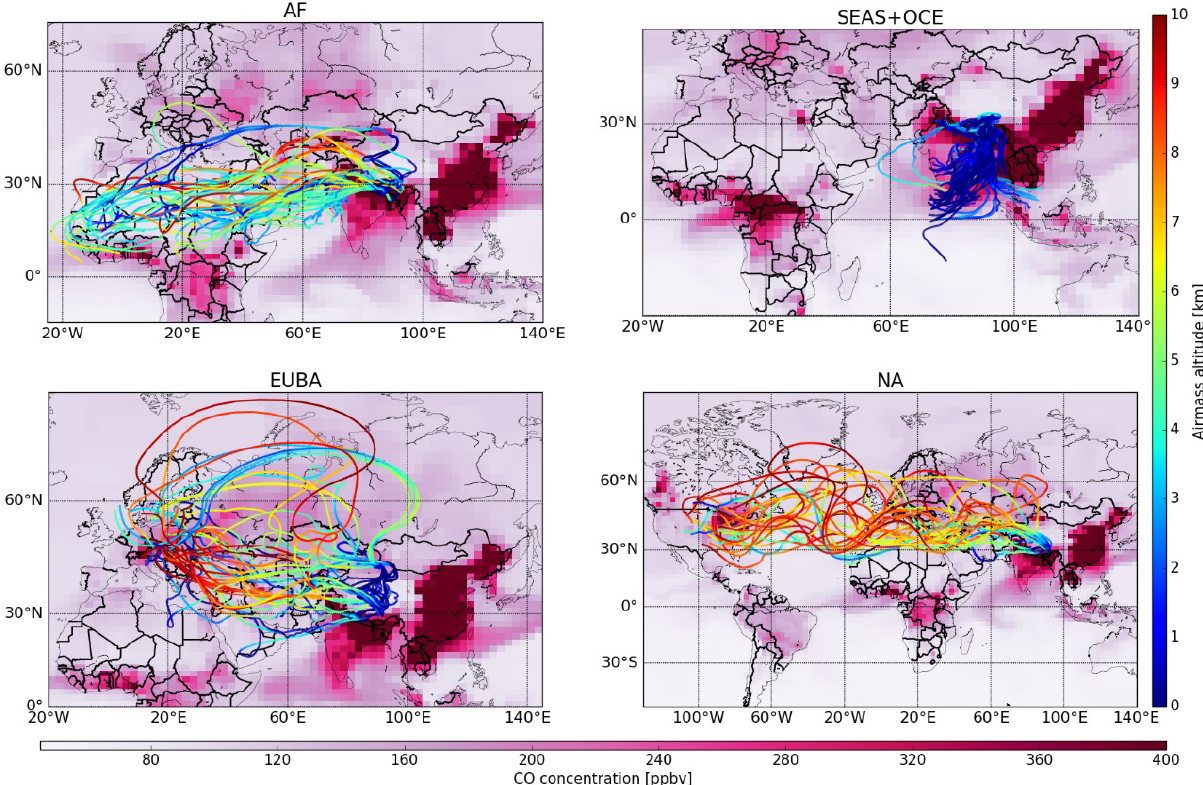
Figure 11. Travel trajectories of polluted air masses originating in AF (SON/DJF), SEAS and OCE (MAM/JJA), EUBA (SON/DJF), and NA (SON/DJF) that reached Naqu (31.5 ◦ N) through long-range transport. For clarity, only a few trajectories are selected for demonstration. Travel times are 13, 7, 10, and 14d, respectively. Global surface CO distributions based on GEOS-Chem simulations are shown for 13, 7, 10, and 14d prior to the arrival time, respectively. The deeper the colour, the higher the CO